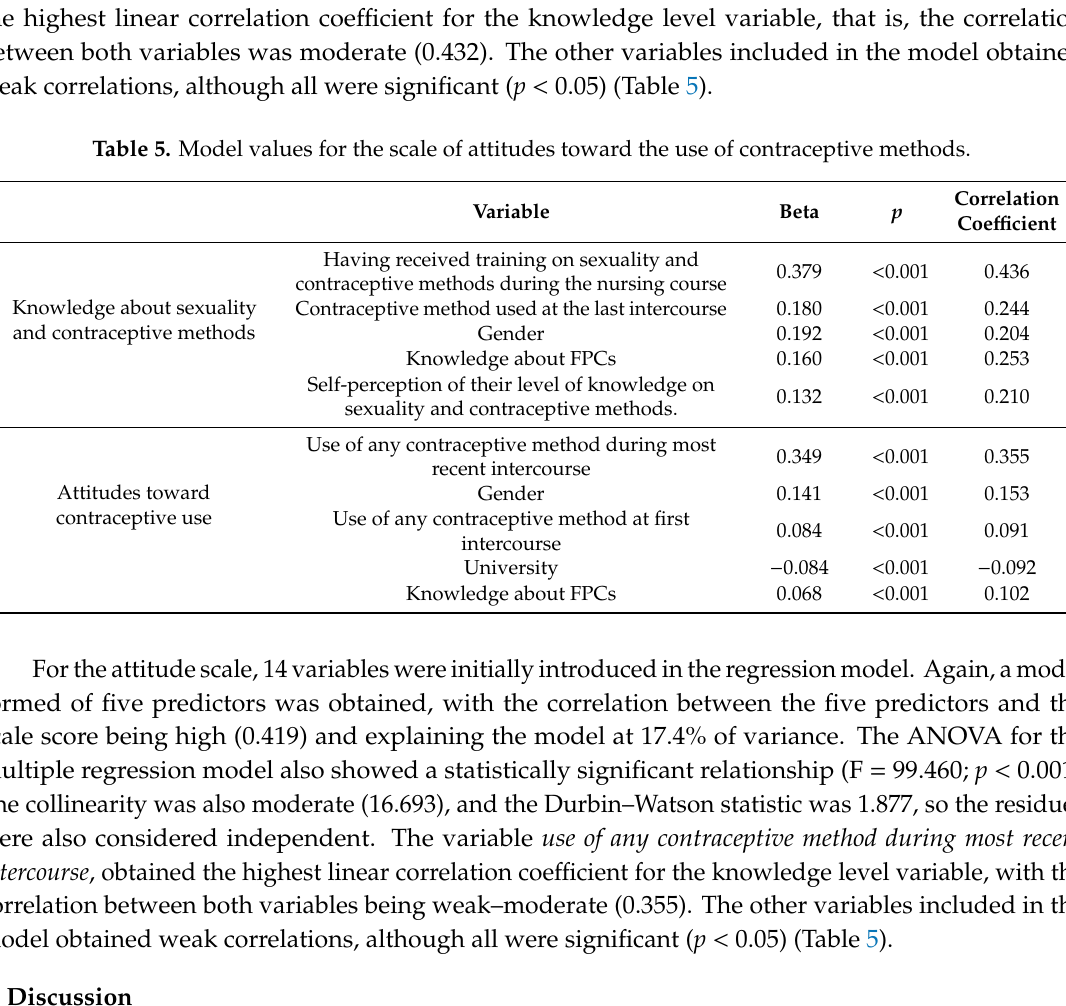
Table 5. Model values for the scale of attitudes toward the use of contraceptive methods.